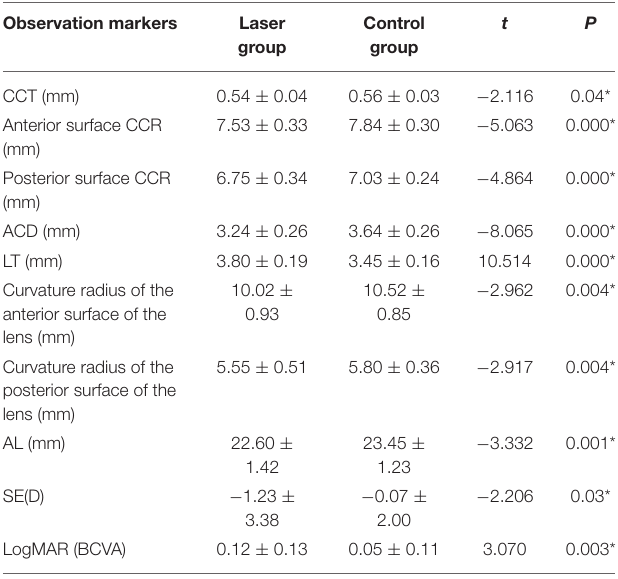
TABLE 2 | Comparisons of ocular biology factors and refractive status in the laser and control groups. Observation